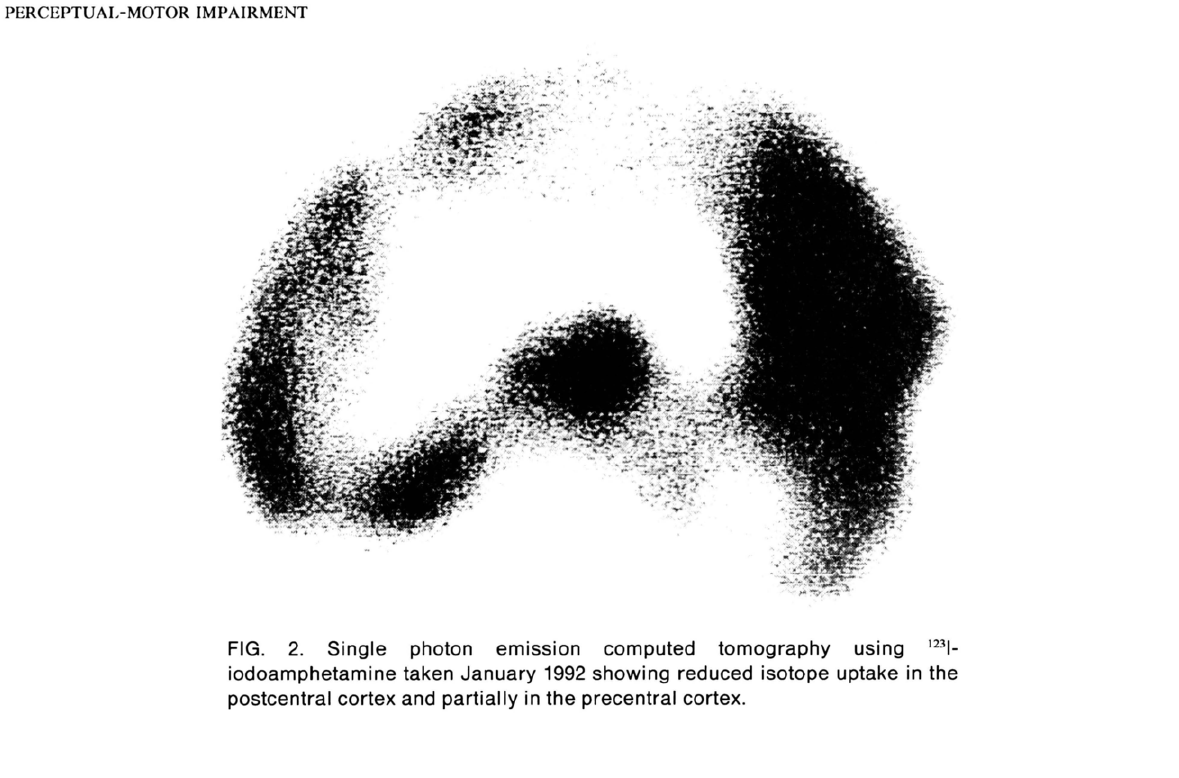
FIG. 2. Single photon emission computed tomography using 1231_ iodoamphetamine taken January 1992 showing reduced isotope uptake in the postcentral cortex and partially in the precentral